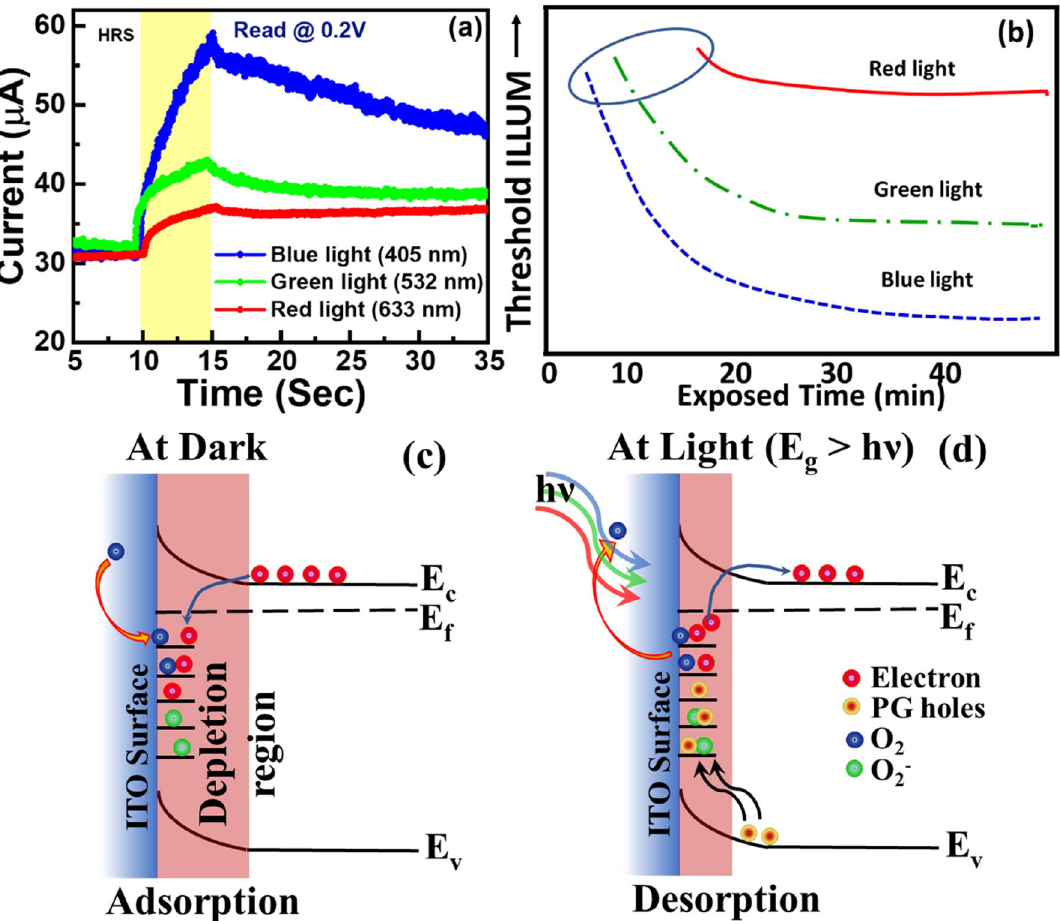
Figure 4. ( a ) Optoelectronic sensitivity of the ISHI-1 after being illuminated with three different wavelengths of light: blue, green and red at HRS after 5 s illumination. ( b ) Representative photopic vision sensitivity of the human eye 32 . Schematic band-diagram of carrier movement during ( c ) dark and ( d ) red, green and blue light irradiation. PG holes means photo-generated